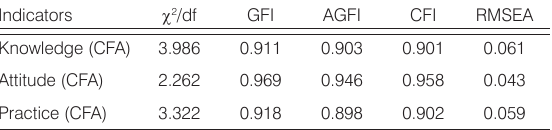
Table 8. GFI indicators for confirmatory factors ( N =